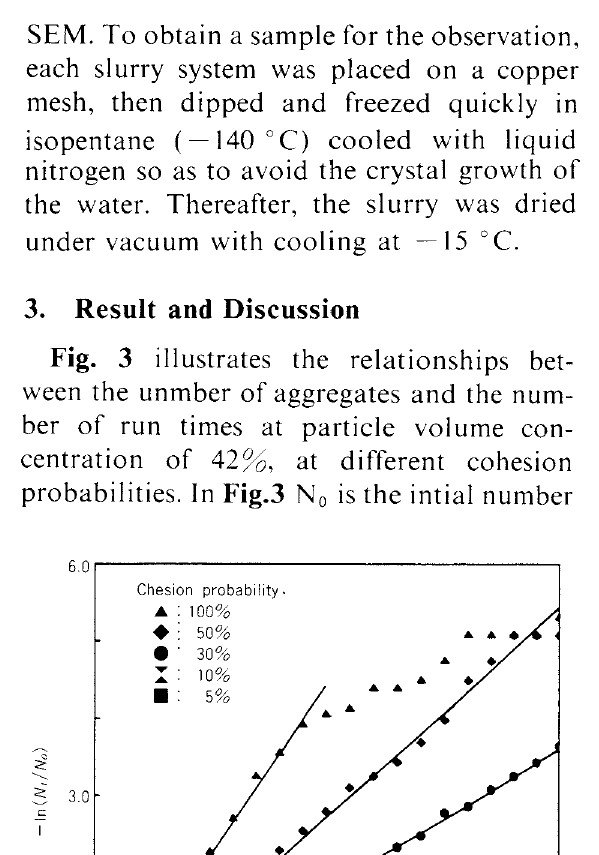
Fig.3 Change in number of aggregates versus run times of the aggregates (805). and N, is the total number of aggregates and dispersed particles at the t-th run time. Table 1 shows the ratios of the gradients (k,) of the straight lines in Fig.3 to that of the straight line at cohesion probability of I 00%. As shown in Fig.3, the decrement retio (k,) of the particles increases with the cohesion probability. that is. there exists correlationship between the cohesion probability and the aggregation rate. As generally recognized, the aggregation process of a monodispersion system at the initial stage is in accordance with the quadratic process represented by the Smoluchowski's